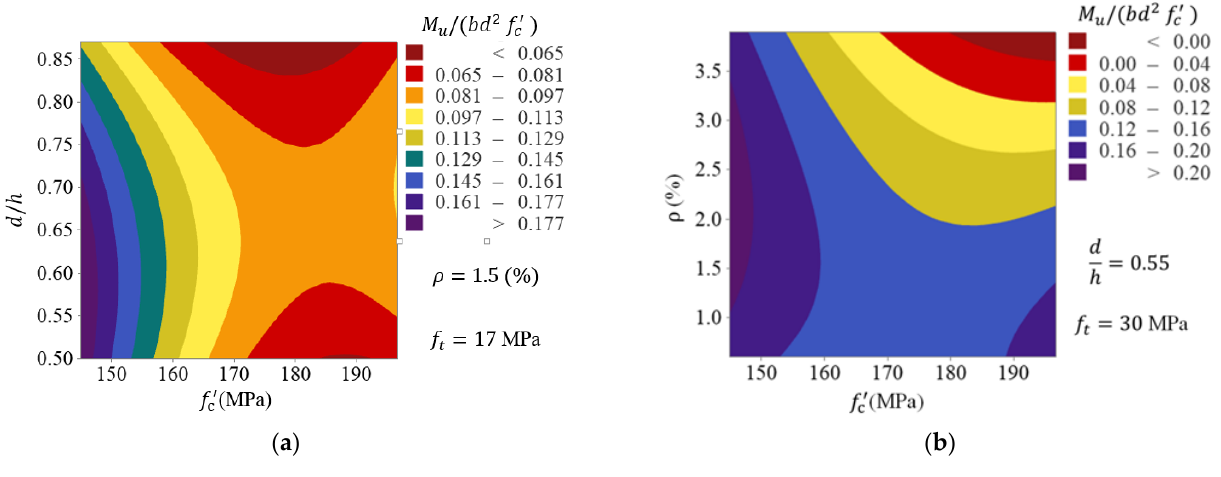
Figure 15. Iso-responses of UHPC beams: ( a ) 𝑑/ℎ − 𝑓 (cid:3030)(cid:4593) , ( b ) 𝜌 − 𝑓 (cid:3030)(cid:4593) .